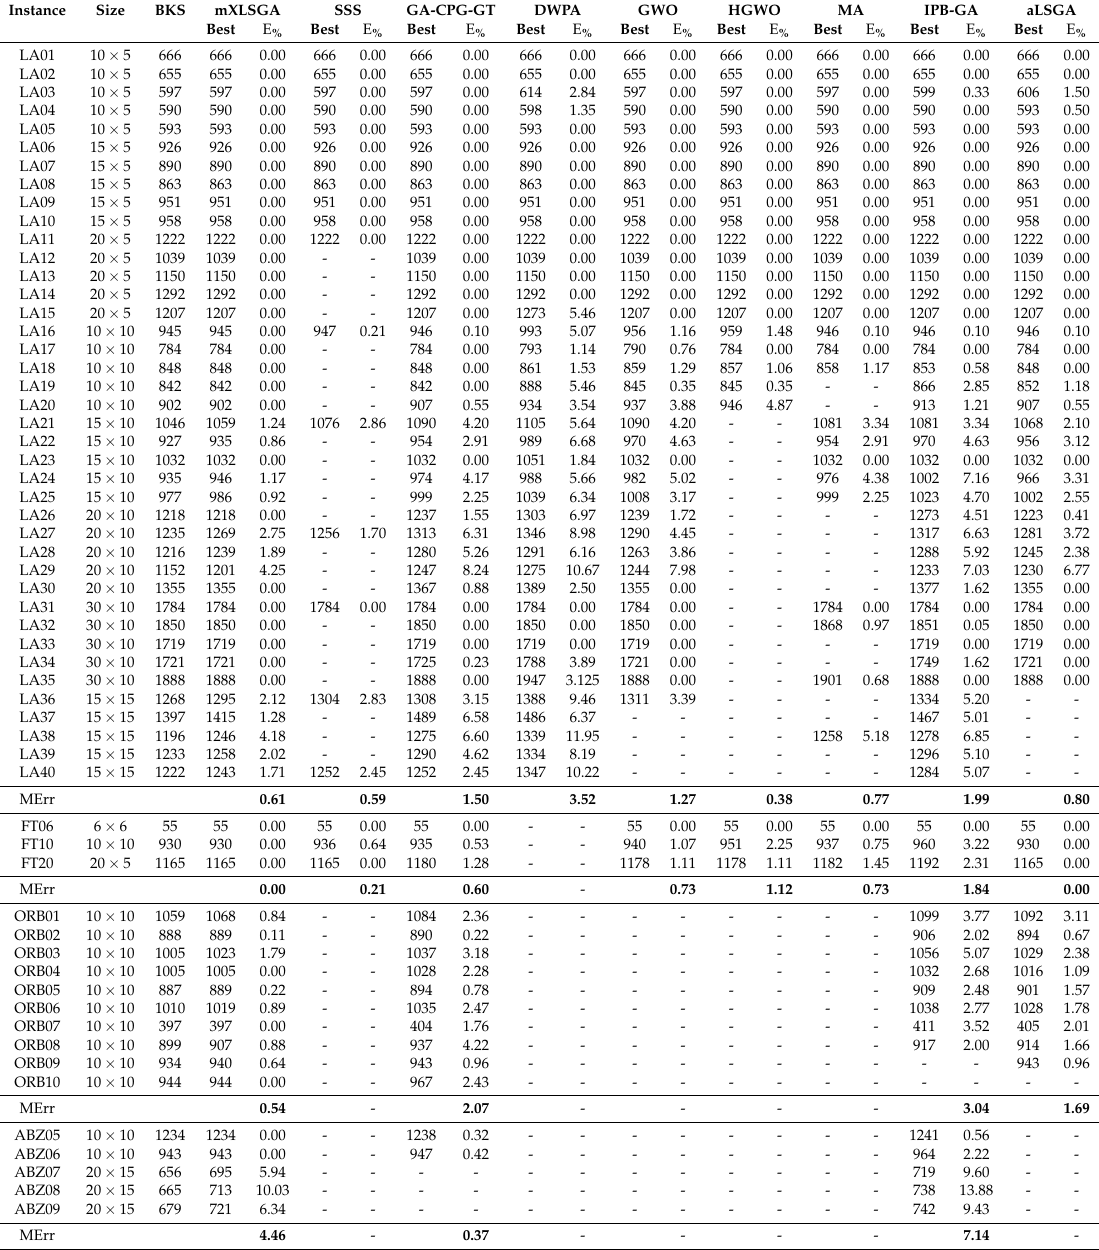
Table 5. Comparison of computational results between mXLSGA and other algorithms. The symbol “-” means “no evaluated in that